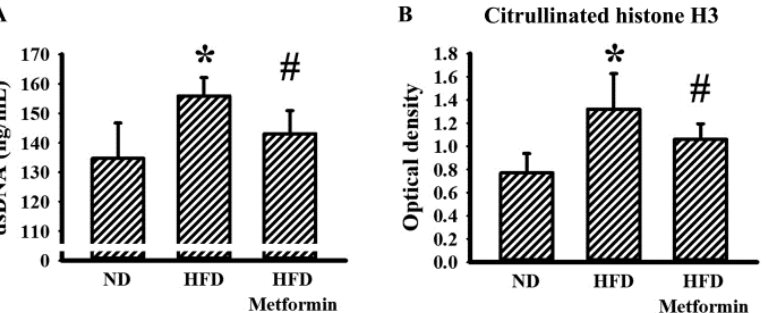
Figure 7. Metformin mitigated circulating parameters of NETs in obese mice. ND-fed lean and HFD-fed obese mice were subcutaneously inoculated with LLC cells over a course of three weeks. Three days after cell implantation, ND-fed lean mice were daily treated with saline vehicle through intraperitoneal injection (ND). HFD-fed obese mice were separated into two groups receiving daily intraperitoneal injections of a saline vehicle (HFD) or metformin (50 mg/kg, HFD/Metformin) for the final 18 days. The levels of dsDNA ( A ) and citrullinated histone H3 ( B ) in blood samples were measured, as described in methodology. * p < 0.05 vs. ND and # p < 0.05 vs. HFD, n = 6.